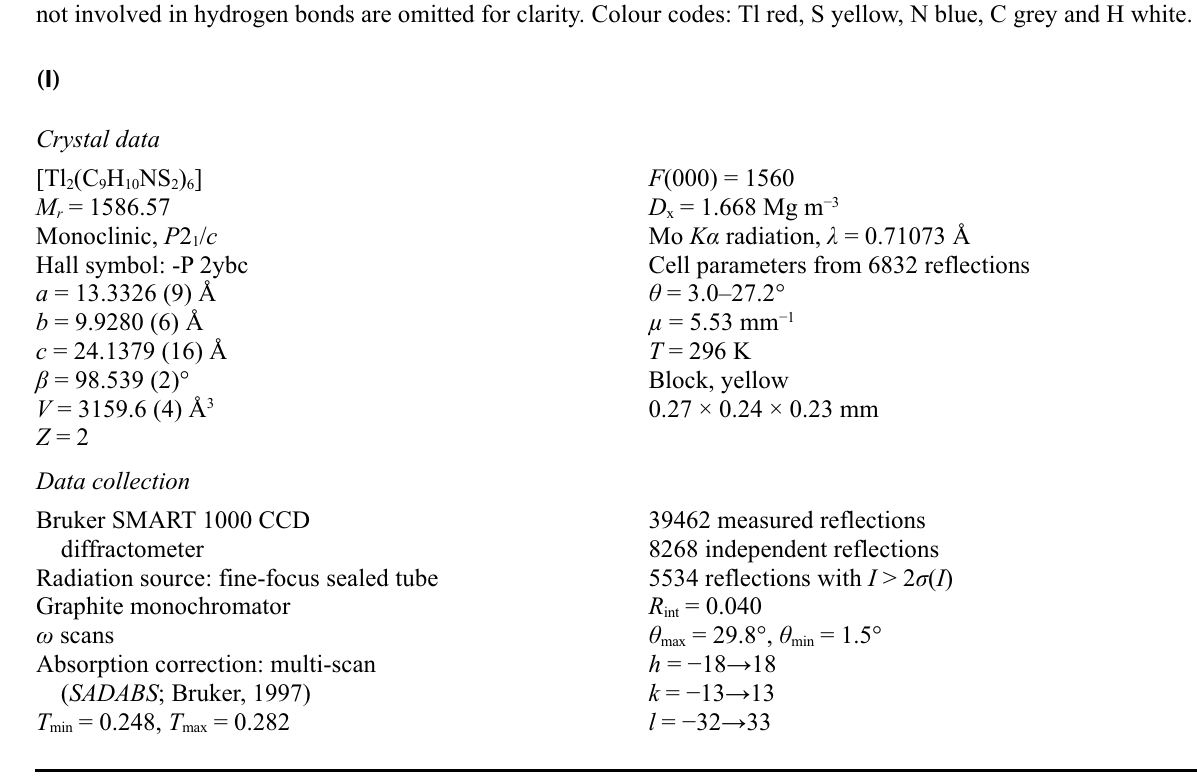
View of the crystal packing of the title compound. Intermolecular hydrogen bonds are shown as dashed lines. H atoms not involved in hydrogen bonds are omitted for clarity. Colour codes: Tl red, S yellow, N blue, C grey and H